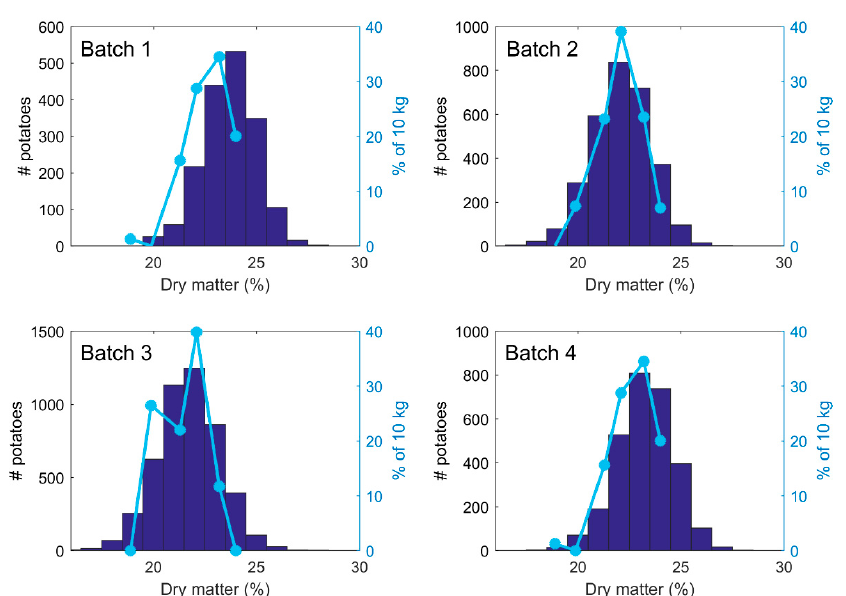
Figure 6. NIR estimated dry matter in four batches of potatoes summarized in histograms. Blue lines indicate distribution of dry matter measured on a 10 kg subsample of the batch.